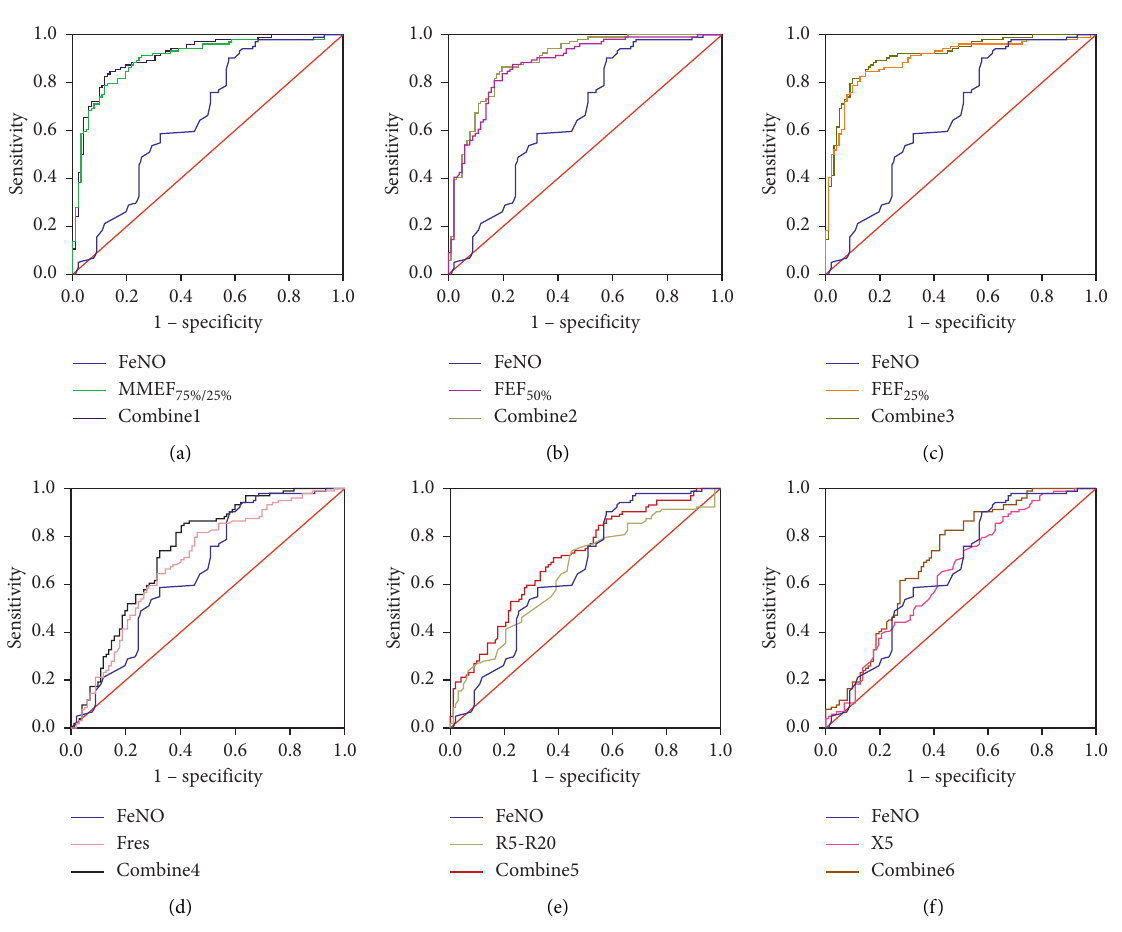
Figure 3: ROC curves for FeNO combined with small airways function in predicting CVA: (a) ROC curves for FeNO combined with MMEF 75%/25% , (b) ROC curves for FeNO combined with FEF 50% , (c) ROC curves for FeNO combined with FEF 25% , (d) ROC curves for FeNO combined with Fres, (e) ROC curves for FeNO combined with R5-R20, (f) ROC curves for FeNO combined with X5. Combine 1: FeNO +MMEF 75%/25% , Combine 2: FeNO+ FEF 50% , Combine 3: FeNO +FEF 25% , Combine 4: FeNO +Fres, Combine 5: FeNO +R5-R20, and Combine 6: FeNO